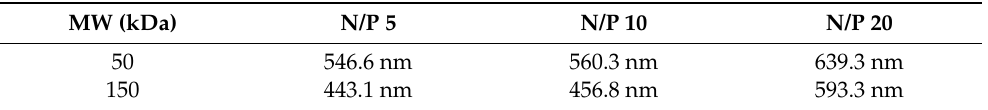
Table 3. Hydrodynamic diameter (nm) of CS/hsDNA complexes prepared with CS of different molecular weights and at different N/P values.